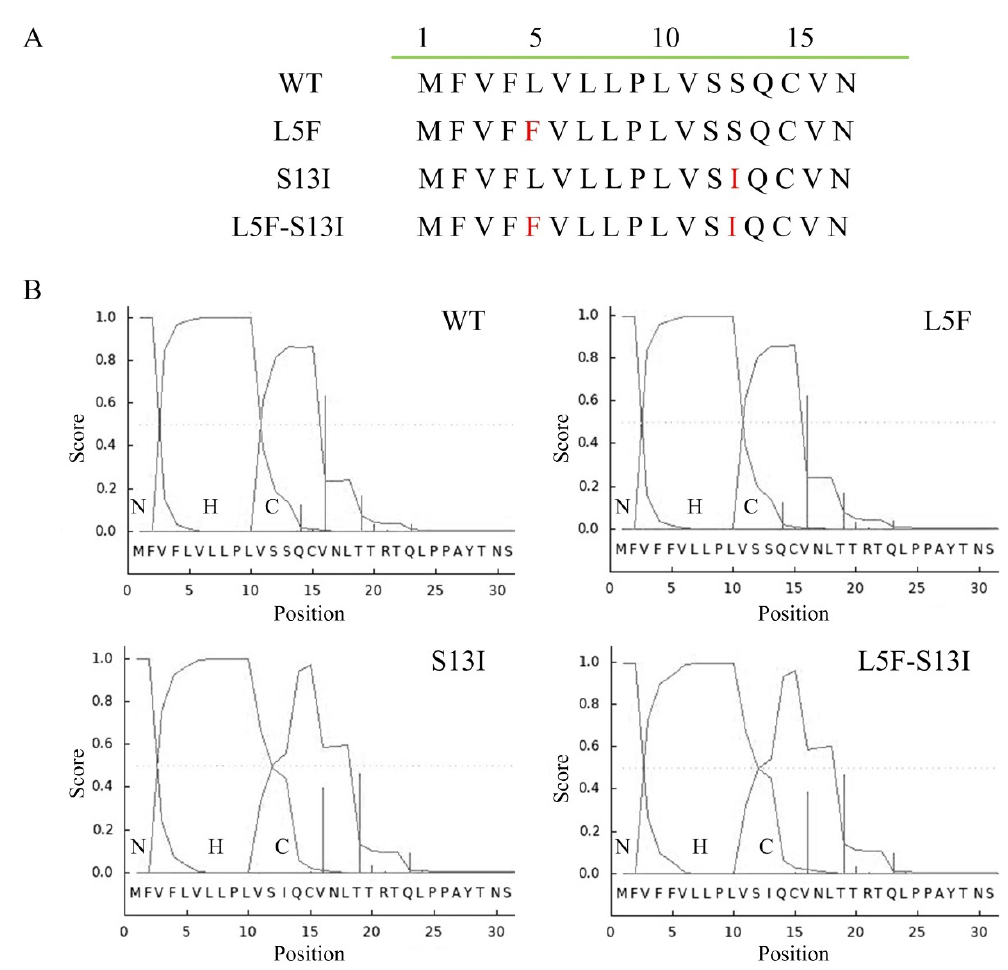
Figure 1. Signal peptide comparison of SARS ‐ CoV ‐ 2 spike protein. ( A ) Signal peptide sequences of SARS ‐ CoV ‐ 2 spike protein. ( B ) Signal peptide structural analysis by SignalP 3.0. WT means wild ‐ type signal peptide of S protein; The mutants L5F and S13I were present in Iota (B.1.526) and Epsilon (B.1.429) variants; L5F ‐ S13I was a newly constructed double mutant.